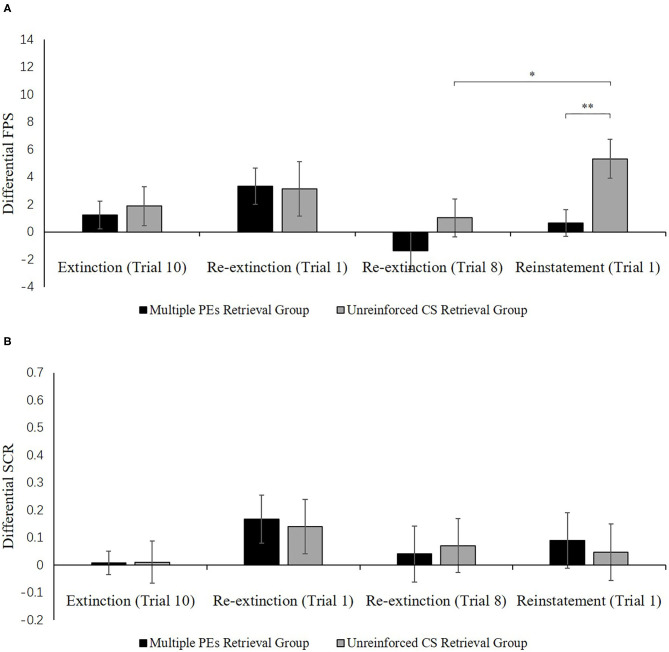
Mean differential FPS (A) and SCR (B) (CS+ minus CS–) during extinction (last trial), re-extinction (first trial; last trial), and reinstatement (first trial) for the experiment 2. Error bars represent SEM. *p < 0.05; **p < 0.01.